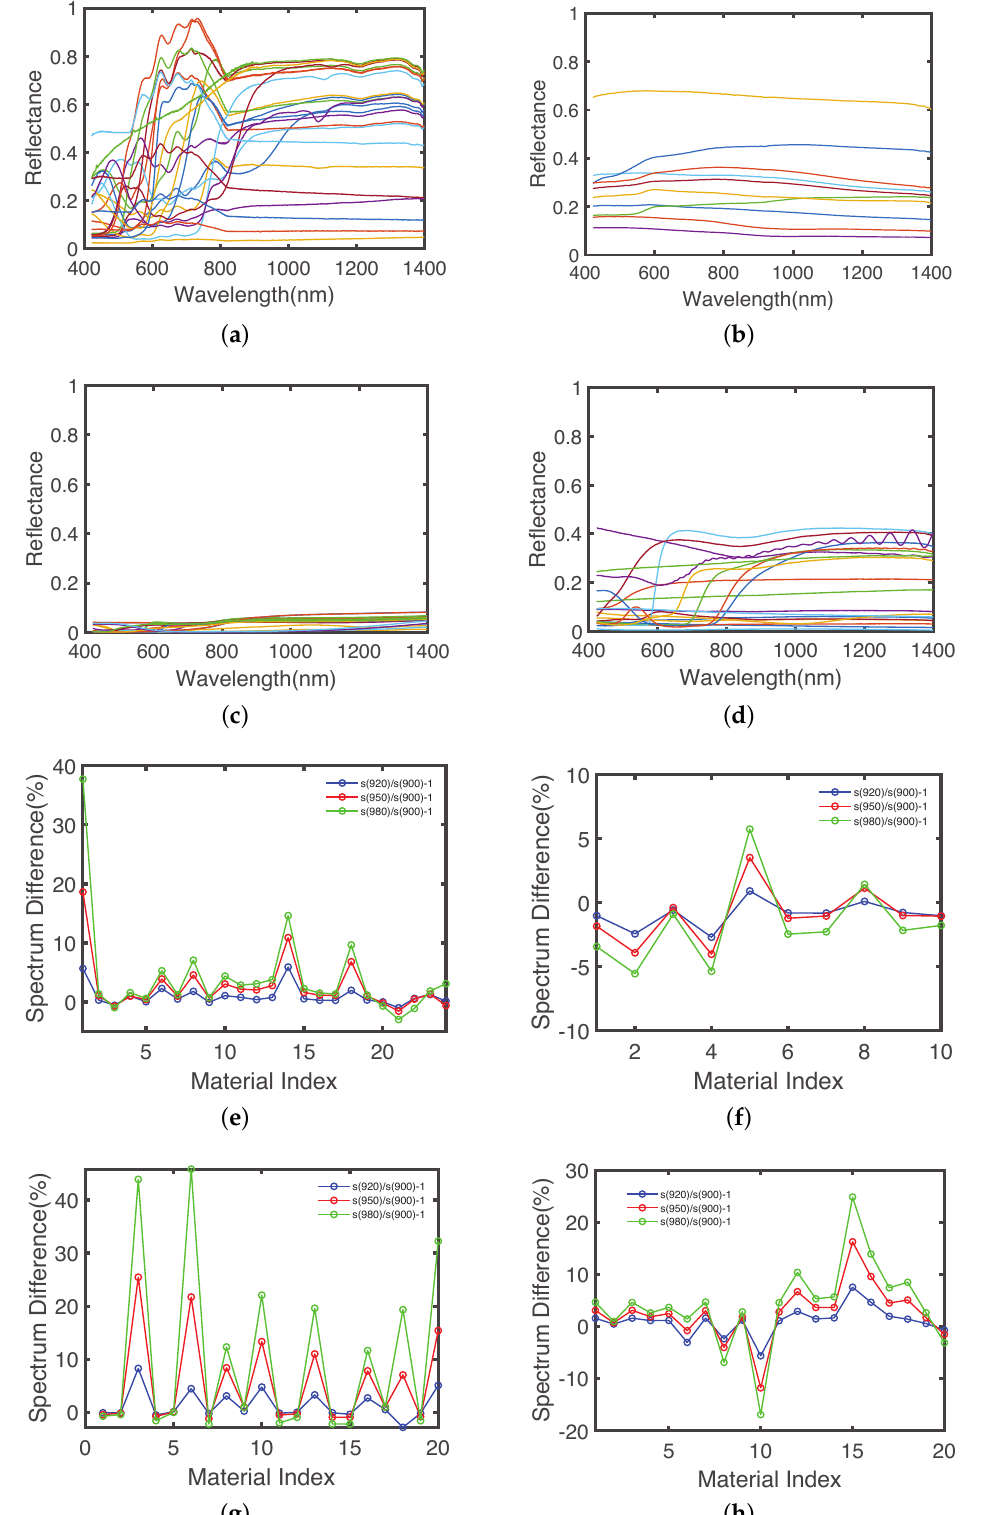
Figure 3. A reflectance spectra database in the Vis-NIR range from 400 to 1400 nm. ( a ) Reflectance spectra of standard colour checker board. ( b ) Reflectance spectra of stones. ( c ) Reflectance spectra of glasses. ( d ) Reflectance spectra of metals. ( e ) Spectrum difference of standard colour checker board. ( f ) Spectrum difference of stones. ( g ) Spectrum difference of glasses. ( h ) Spectrum difference of